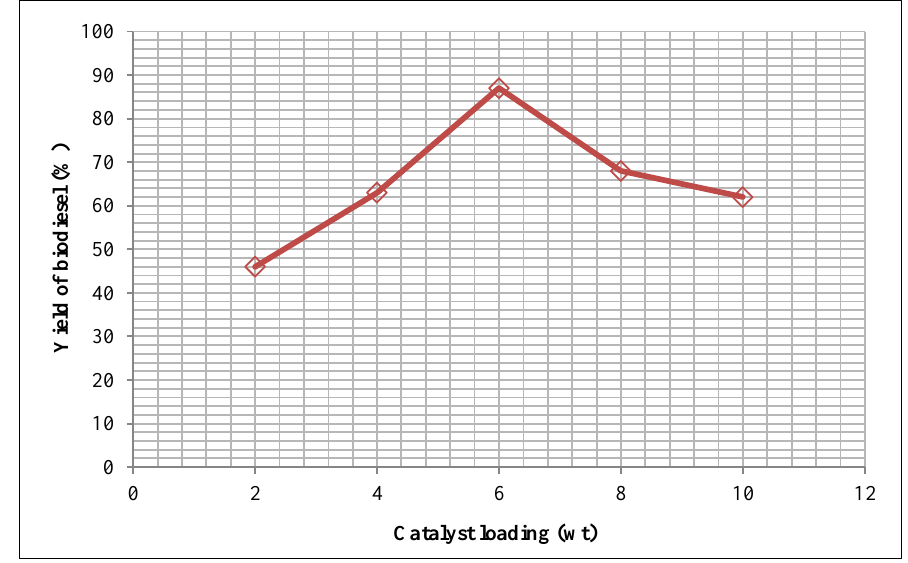
Figure 5. Effect of catalyst loading on biodiesel yield